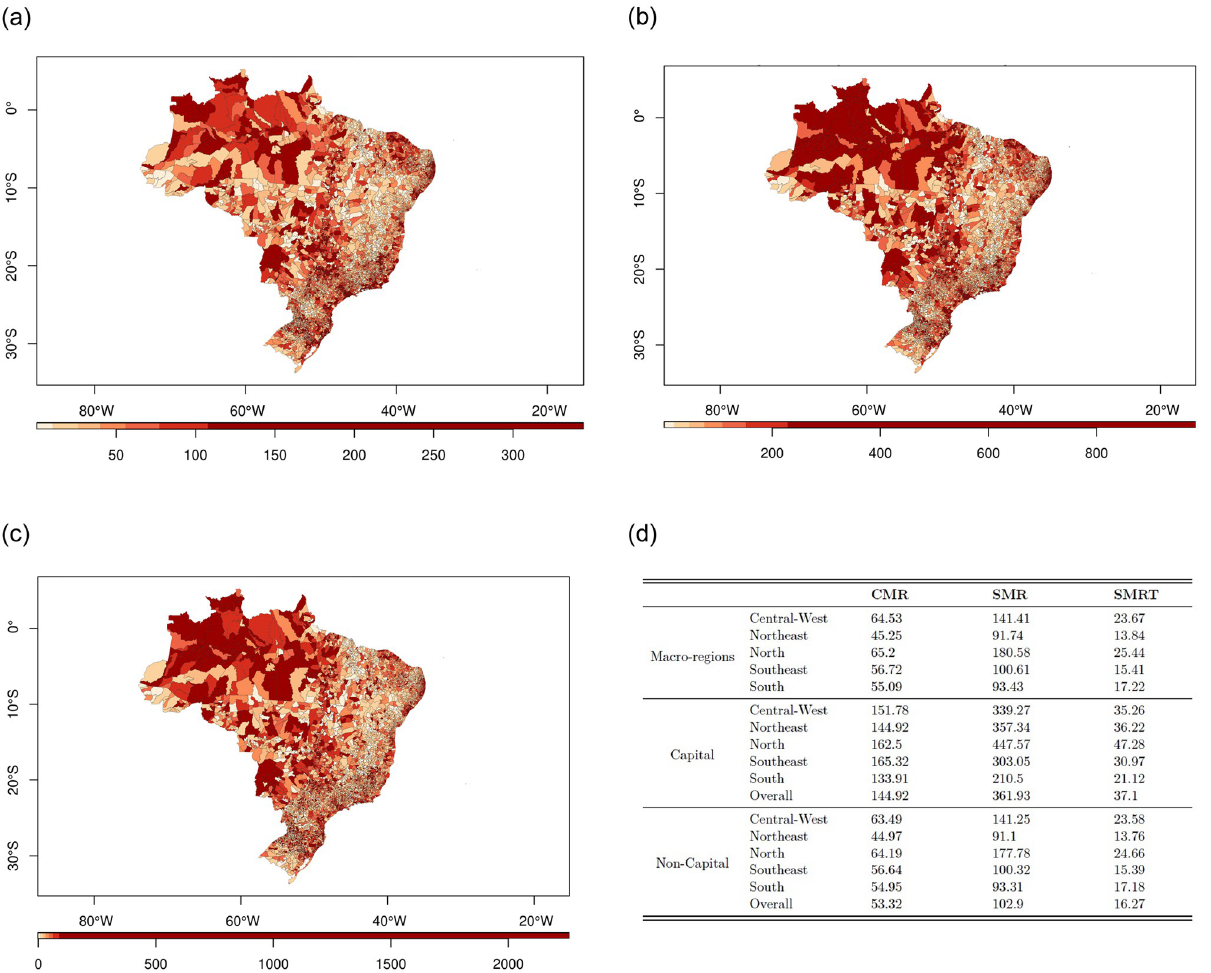
Fig 1. Brazilian national map by municipalities with distribution of mortality rates (a, b and c) and medians of mortality rate by geographic locations (d). Brazil, 2020. (a) CMR. (b) SMR. (c) SMRT. (d) Mortality Rate Medians.